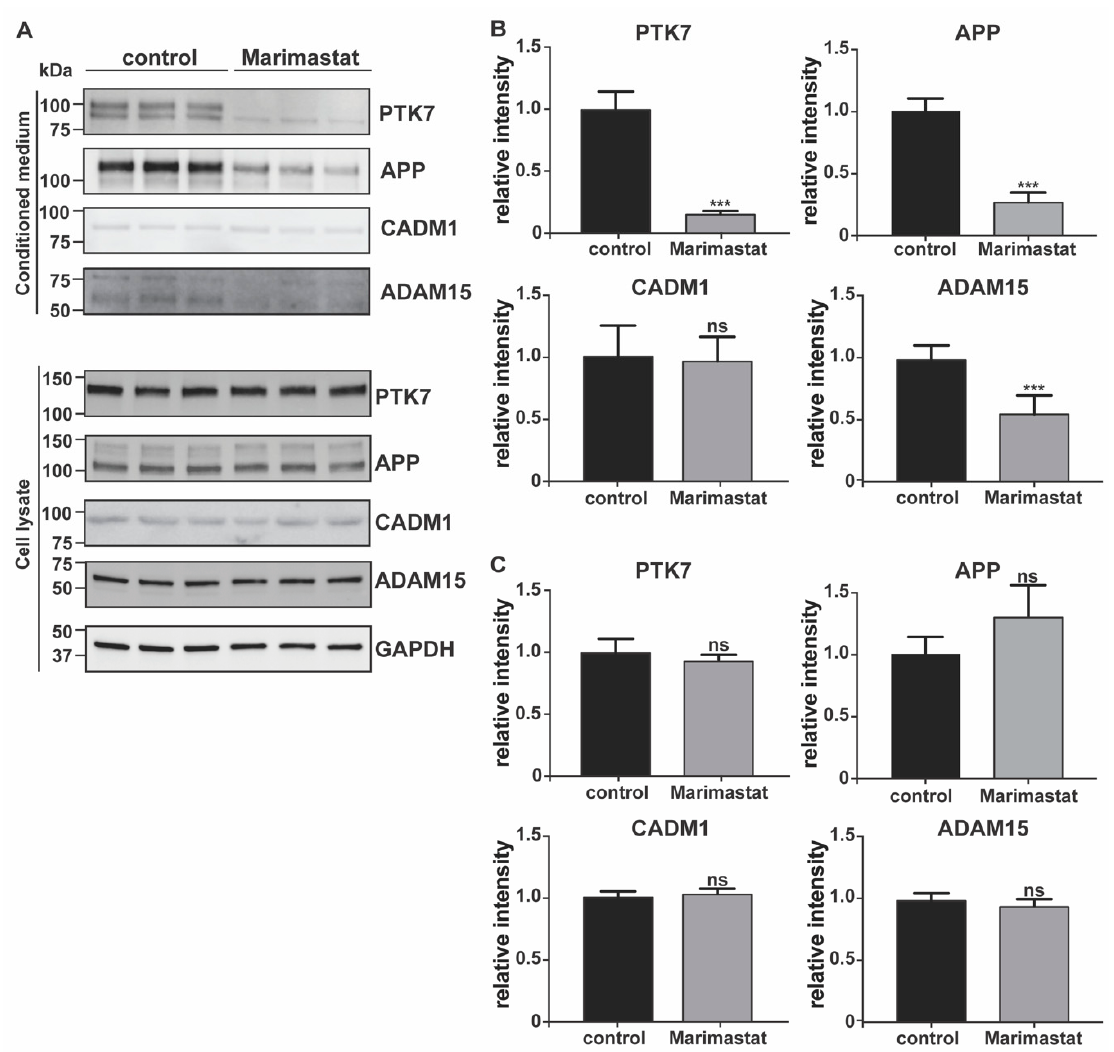
Figure 4. Validation of metalloprotease-dependent shedding of TIMP-3 regulated proteins by immunoblotting. Immunoblots ( A ) and their respective quantification ( B , conditioned media; C , cell lysates) showing levels of PTK7, APP, CADM1, and ADAM15 in conditioned media or lysates of HEK 293 cells treated with or without marimastat (control). GAPDH was used as a loading control. Densitometric quantifications shown as mean values ± standard deviation; *** p < 0.005, Student’s t-test; ( n = 6).